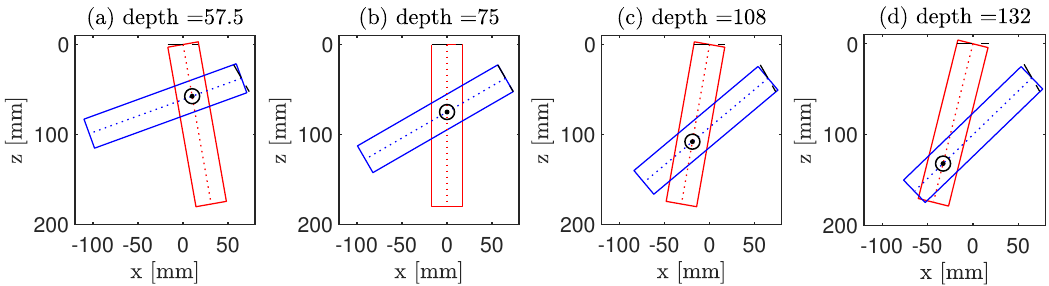
Figure 4. Schematic representation of the spatial location of the two linear arrays, T1 (red) and T2 (blue), and their FOV at different imaging depths. The circle indicates the centre of the common FOV, which defines the imaging depth in CoMTUS. Four different imaging depths are shown: ( a ) 57.5 mm; ( b ) 75 mm; ( c ) 108 mm; and ( d ) 132